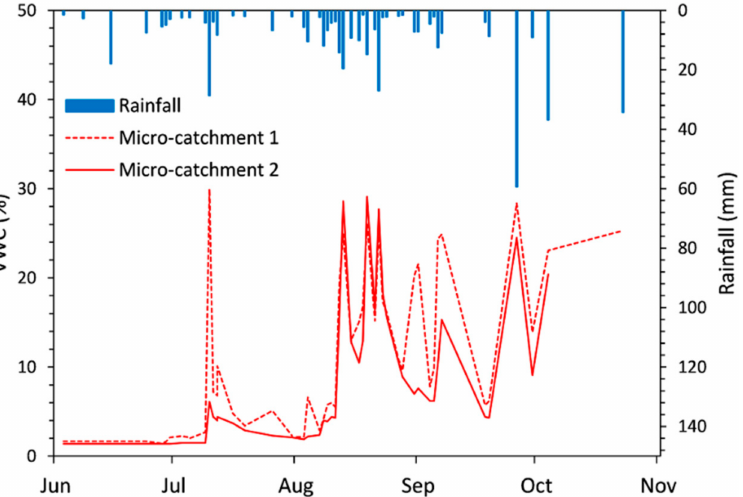
Figure 4. Mean soil moisture by rainfall event before thinning (2018) for micro-catchments 1 and